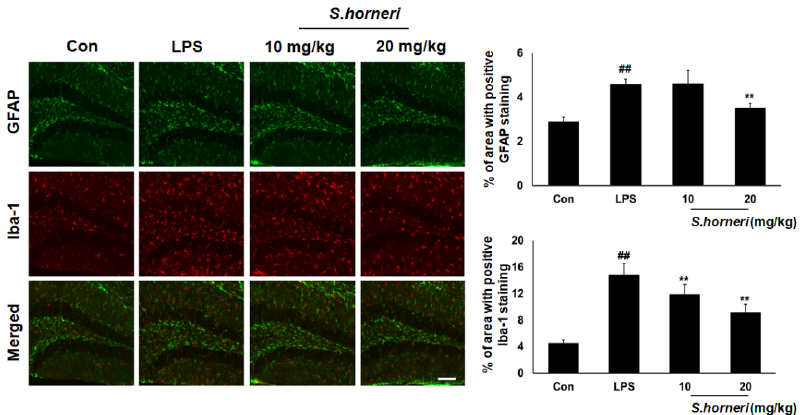
Figure 5. S. horneri inhibited LPS-induced astrocyte and microglia activation in brain hippocampus. C57BL/6 mice were randomly divided into four groups. The control group was challenged with the same amount of solvent i.p. ( n = 5). The treatment group was administered LPS (1 mg/kg) and S. honeri (10 and 20 mg/kg), following in vivo study design. Brain sections were immunostained with